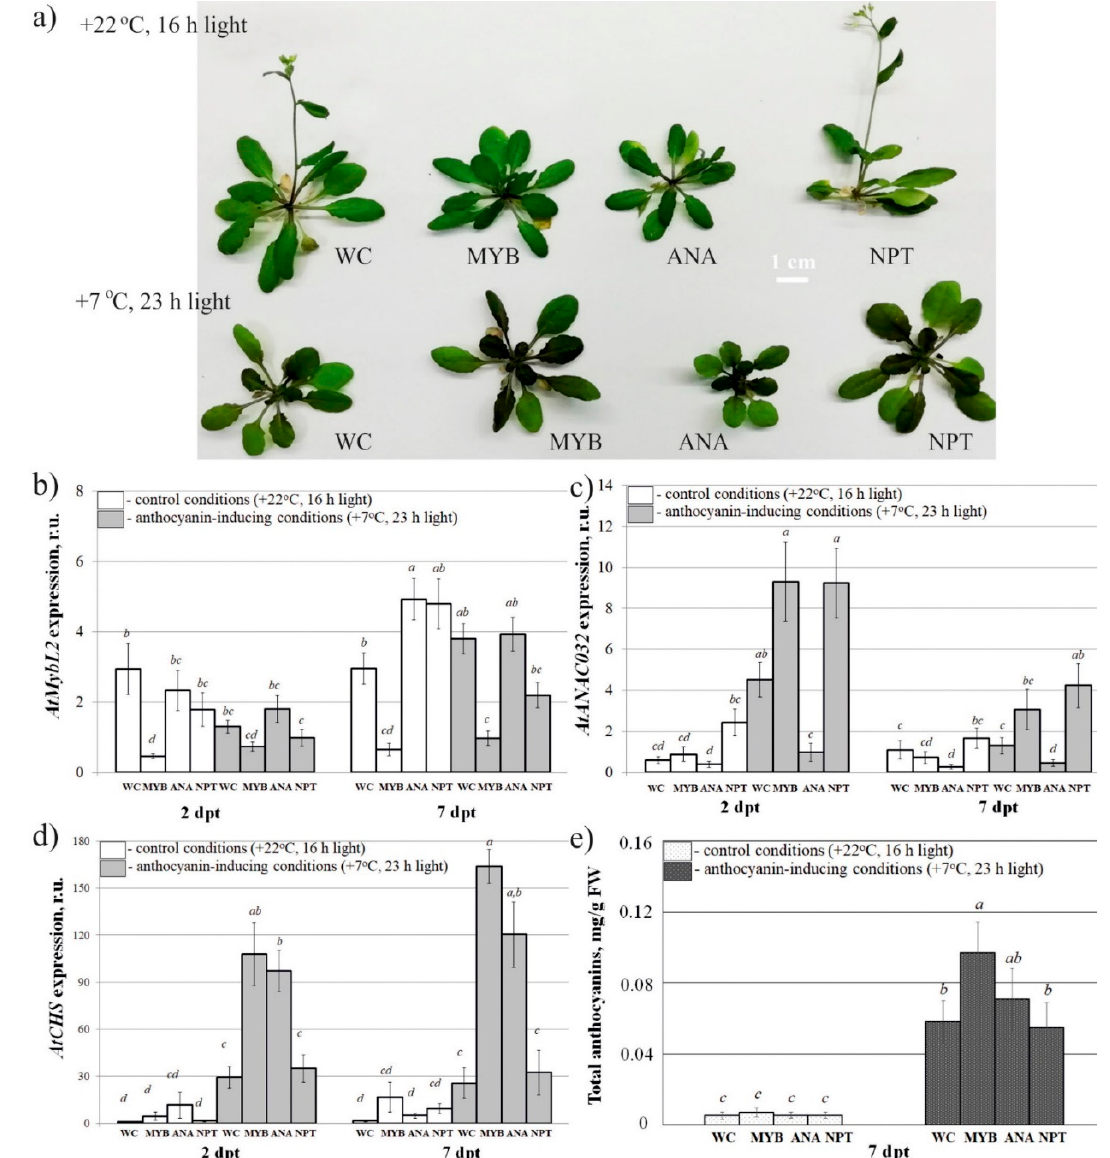
Figure 6. The effect of external AtMYBL2 -, AtANAC032- , and NPTII -encoding dsRNAs on AtMYBL2 , AtANAC032 , and AtCHS mRNA levels and total anthocyanin content in Arabidopsis thaliana . ( a ) Arabidopsis plants grown under control (+22 °C, 16 h light, upper panel) and anthocyanin-inducing (+7 °C, 23 h light, lower panel) conditions for seven days after treatment with sterile water or synthetic dsRNAs. ( b ) Quantitative real-time PCR measuring relative mRNA levels of endogenous AtMYBL2 in the leaves of A. thaliana treated with water or synthetic dsRNAs. ( c ) Quantitative real-time PCR measuring relative mRNA levels of endogenous AtANAC032 in the leaves of A. thaliana treated with water or synthetic dsRNAs. ( d ) Quantitative real-time PCR measuring relative mRNA levels of endogenous AtCHS in the leaves of A. thaliana treated with water or synthetic dsRNAs. ( e ) HPLC results of the total anthocyanin content in the leaves of A. thaliana grown at the control and anthocyanin-inducing conditions. WC— A. thaliana treated with sterile water; MYB— A. thaliana treated with AtMYBL2 -dsRNAs; ANA— A. thaliana treated with AtANAC032 -dsRNAs; NPT— A. thaliana treated with NPTII -dsRNA; dpt—days post-treatment. The data are presented as the mean ± SE (three independent experiments). Means followed by the same letter were not different using Student’s t test. p < 0.05 was considered statistically significant.